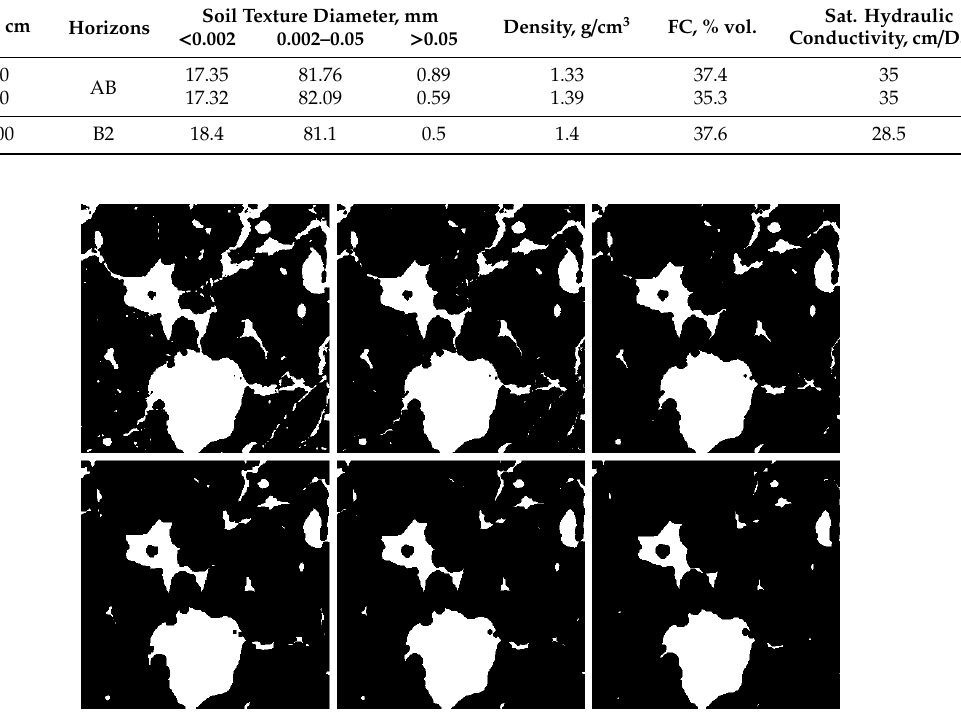
Figure A1. An example of morphological erosion operation applied with structural units of different sizes for images of samples from the arable soil horizon. Voids are white and solid phase is black.